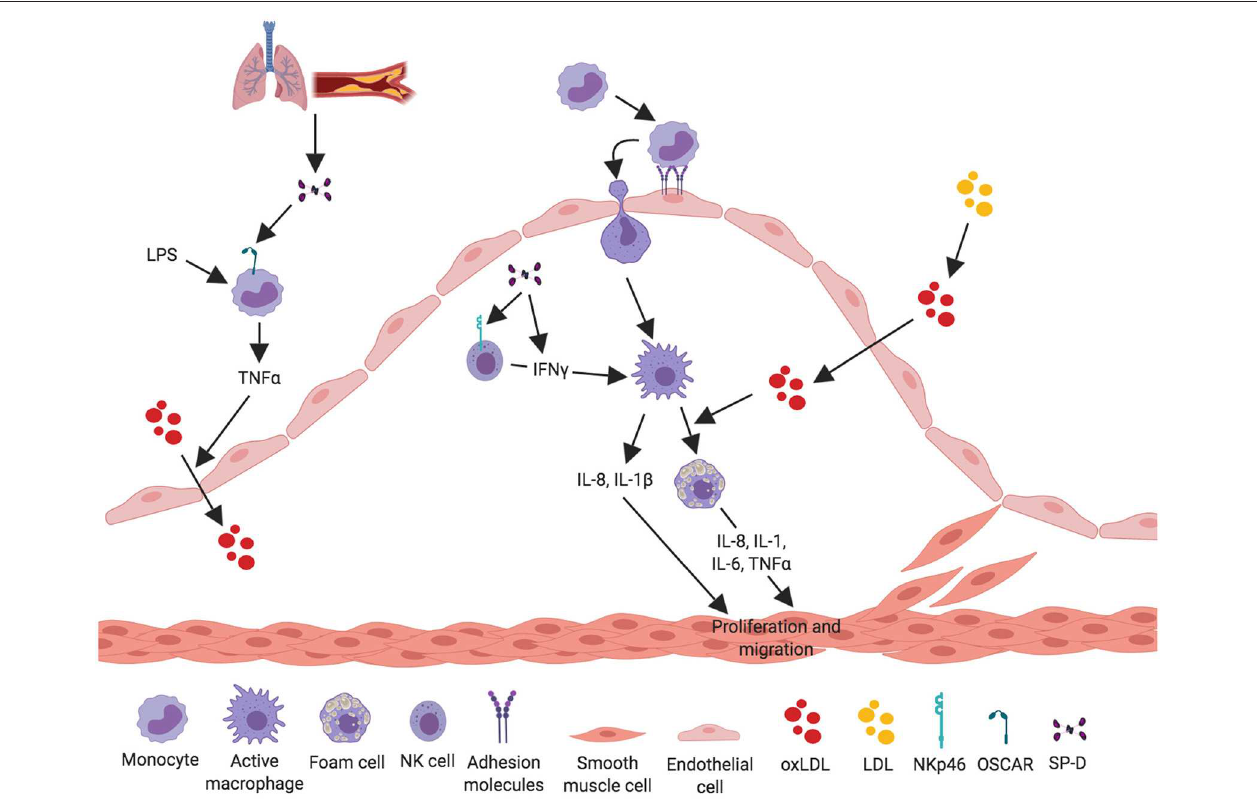
FIGURE 3 | Proposed pro-inflammatory mechanisms for SP-D in the development of atherosclerosis. SP-D plays a dual role in the development of atherosclerosis. The figure aims to depict what we know about the pro-inflammatory properties of SP-D in the development of atherosclerosis. SP-D is actively contributing to the inflammatory process in the artery. SP-D stimulates LPS-induced TNF- α -secretion from CCR2 + inflammatory monocytes through binding via its receptor OSCAR. TNF- α stimulates translocation of oxidized LDL from the artery lumen to the subendothelial space and thus contributes to the atherosclerotic plaque formation. The pro-inflammatory role of SP-D is also mediated through NK cells, where SP-D binds the receptor NKp46 leading to secretion of IFN- γ , which activates macrophages. Activated macrophages secrete the cytokines IL-8 and IL-1 and are able to engulf the oxidized LDL, leading to foam cell formation and production of IL-8, IL-1, IL-6, and TNF- α . These cytokines stimulate and activate VSMC to proliferate and migrate to stabilize the growing atherosclerotic